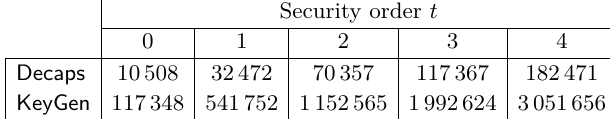
Table 10: Cycle counts for decapsulation and key generation of ntruhps2048509 on a Cortex-M3 CPU, in thousands of